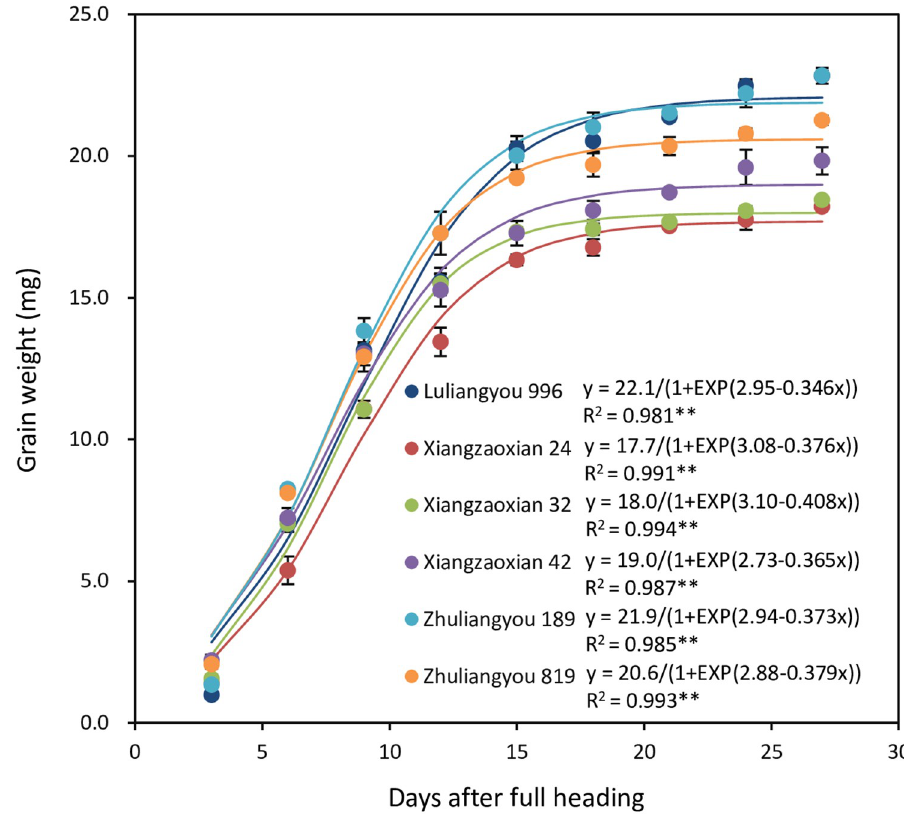
Fig 2. Grain-filling process fitted by logistic equation for six early-season rice cultivars. �� denotes significance at the 0.01 probability level.